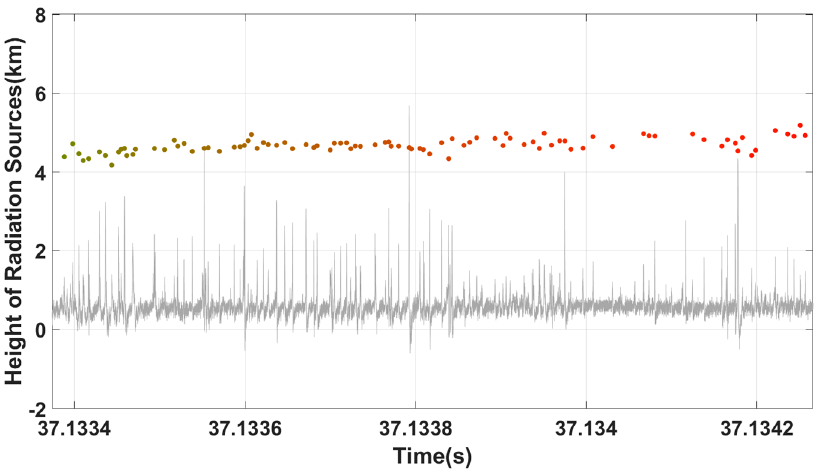
Figure 7. The height of the radiation sources corresponding to the pulses in Figure 5. As shown in Figure 8, the old method located 568 radiation sources for IC flash 001136. Progressively, the new method located 3699 radiation sources for the same lightning flash, as shown in Figure 9. The number of located radiation sources has increased by nearly a factor of seven. Compared with the old method, the positioning results of the new method are significantly improved, which is mainly due to the much larger number of positioning points (matched pulses). The two main reasons for this significant improvement are the increase in the number of extracted pulses and the application of Pearson